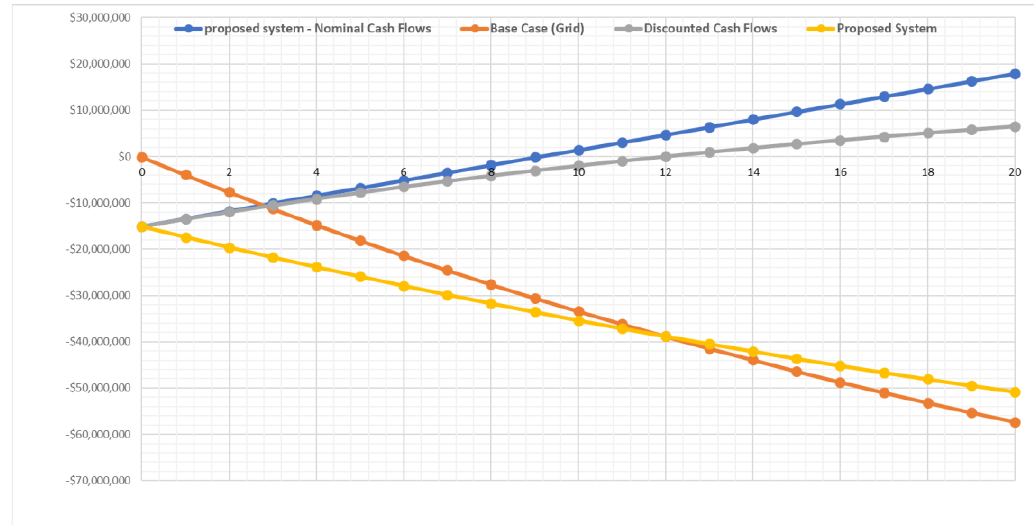
Figure 11. Discounted cash flow Vs nominal cash flow .